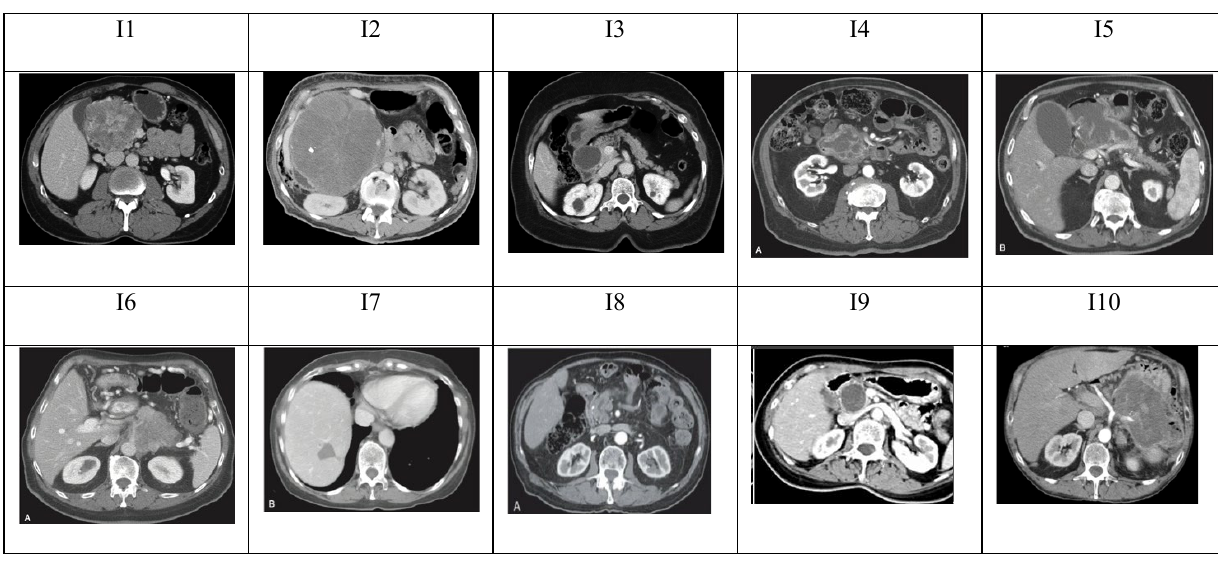
Figure 8. Original CT Images of Pancreatic